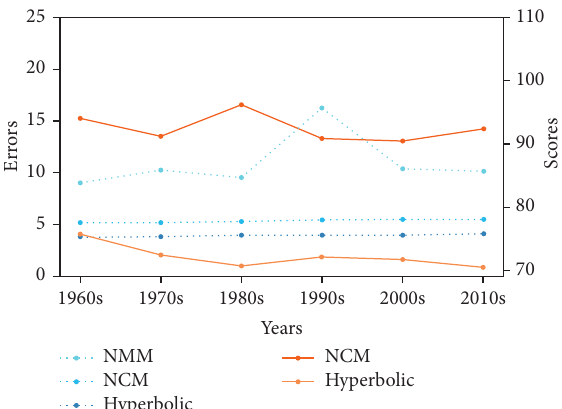
Figure 4: The error functions and embedding scores of GMNs in Euclidean and hyperbolic planes for